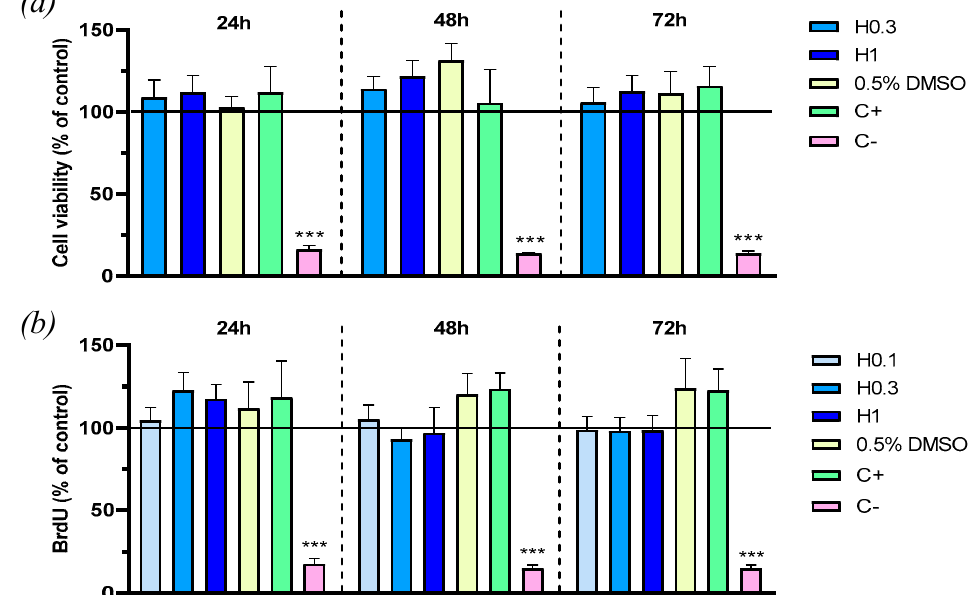
Figure 1. Hidrosmin-related effects on viability and cytotoxicity of HK2 cells: ( a ) MTT cell viability at 24, 48, and 72 h of incubation in medium with 0.5% FBS containing hidrosmin (H, 0.3 and 1 mM), vehicle of 1mM hidrosmin (0.5% DMSO), 20% FBS (positive control, C+), and 10% DMSO (negative control, C − ); ( b ) BrdU cell proliferation assay at 24, 48, and 72 h incubation in medium with 10% FBS containing hidrosmin (H, 0.1, 0.3 and 1 mM), vehicle (0.5% DMSO), 20% FBS (C+) and 10% DMSO (C − ). Bars represent the mean ± SEM of 6 experiments. *** p < 0.001 vs. basal (black